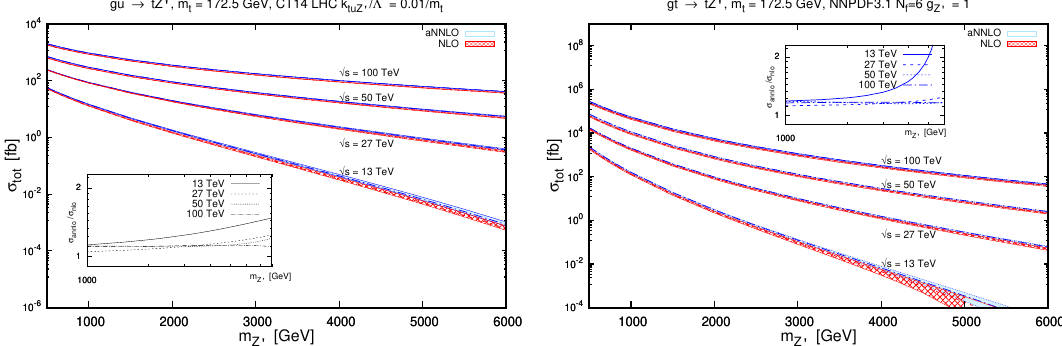
Figure 5: Cross sections vs. Z (cid:48) mass for tZ (cid:48) production via anomalous t - u - Z (cid:48) cou- plings (left) and via initial-state tops